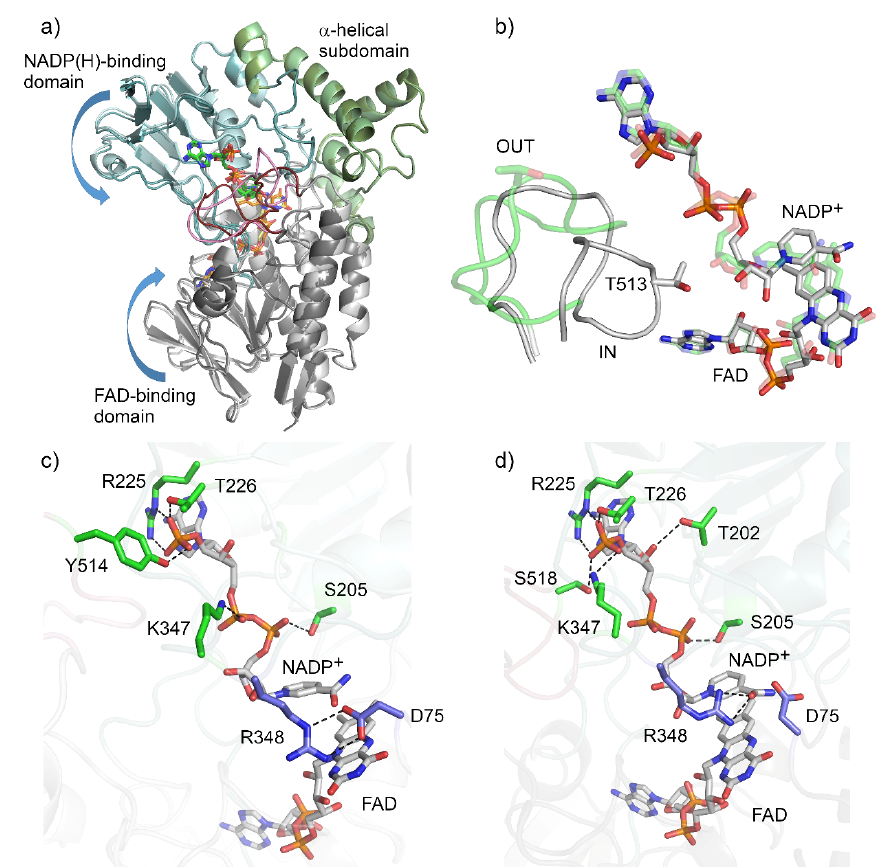
Figure 2. Crystal structure of BVMO AFL210 . ( a ) Ribbon diagrams showing an overlay of the ‘open’ vs. ‘closed’ conformations of BVMO AFL210 , with the FAD and NADP modelled as sticks. The ‘closed’ conformation is shaded darker with the FAD-binding domain (grey), NADPH-binding domain (blue), the α -helical subdomain (green) and the ‘control loop’ in pink. ( b ) FAD and NADP + cofactors and the ‘control loop’ of BVMO AFL210 in the ‘open’ (transparent green) and ‘closed’ conformation. NADP + binding and active site architecture of BVMO AFL210 in the ‘open’ ( c ) and ‘closed’ ( d )